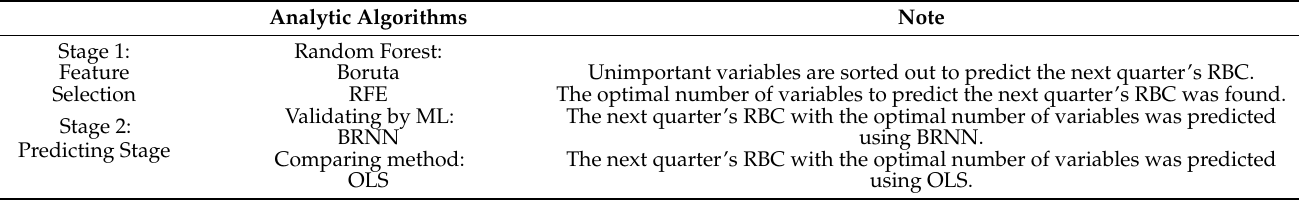
Table 1. Analytic Algorithms in the